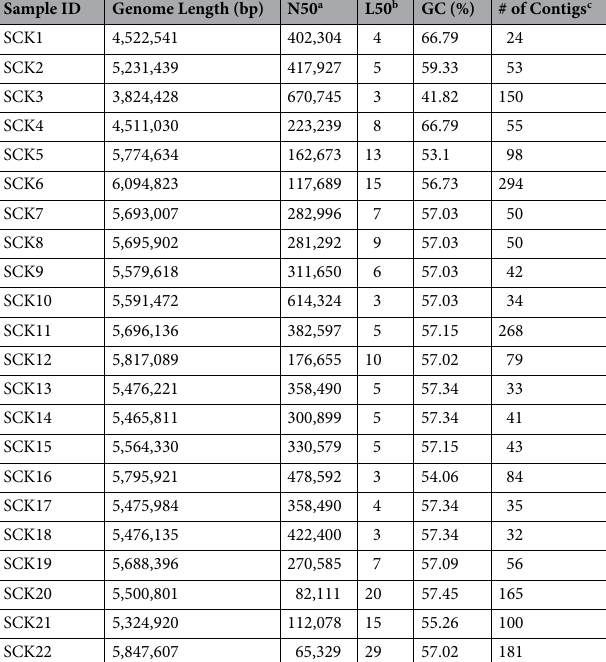
Table 1. Genome assembly statistics for the isolates characterized here. a When the contigs of an assembly are arranged from largest to smallest, N50 is the length of the contig that makes up at least 50% of the genome. b L50 is the number of contigs equal to or longer than N50. c Number of contigs ≥ 500 bp in